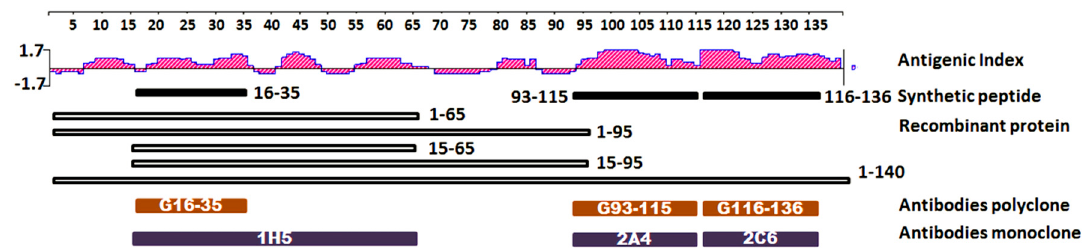
Figure 1. Antigenicity, recombinant protein, and related antibodies detected domains of Human α -synuclein. Antigenic Index was predicted by the Jameson-Wolf method using DNAstar. Antibodies G16-33, G93-115, and G116-136 are polyclonal antibodies produced in goats. Antibodies 1H5, 2A4, and 2C6 are all monoclonal antibodies produced in mice. Recombinant proteins were expressed in E. coli and were purified using affinity chromatography. Table 1. Mouse monoclonal antibody binding domain mapping. Antibodies were mapped using plates coated with di ff erent synthetic peptides ( α -syn12-38, α -syn1-106, α -syn93-115, α -syn116-136, α -syn93-116, and α -syn107-140) for direct ELISA assays. The binding domains of 2A4 and 2C6 are human α -syn93-115 and human α -syn116-136, respectively. The binding domain for 1H5 was narrowed down to the N-terminus. Western blotting results listed below confirmed the domain located within human α -syn15-65. (- ≤ 0.05; 0.05< * ≤ 0.1; 0.1 < ** ≤ 0.5; 0.5 < *** ≤ 1.0; **** >1.0) In